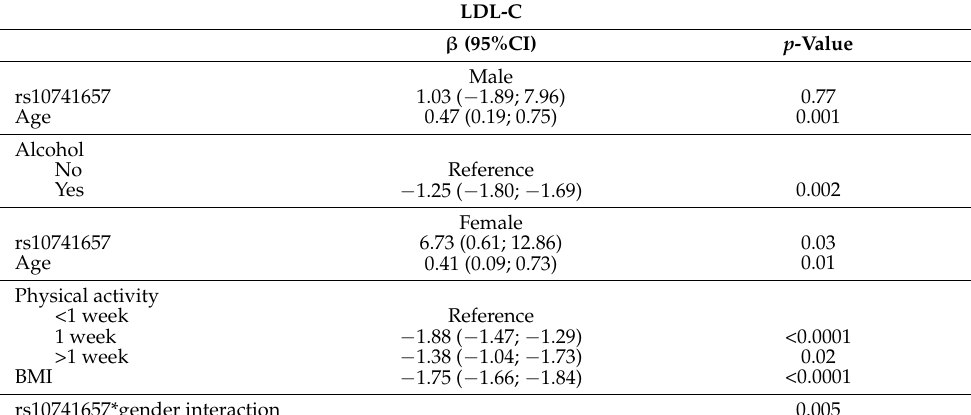
Table 3. Interaction analysis between rs10741657 and gender on low-density lipoprotein cholesterol, using stepwise regression